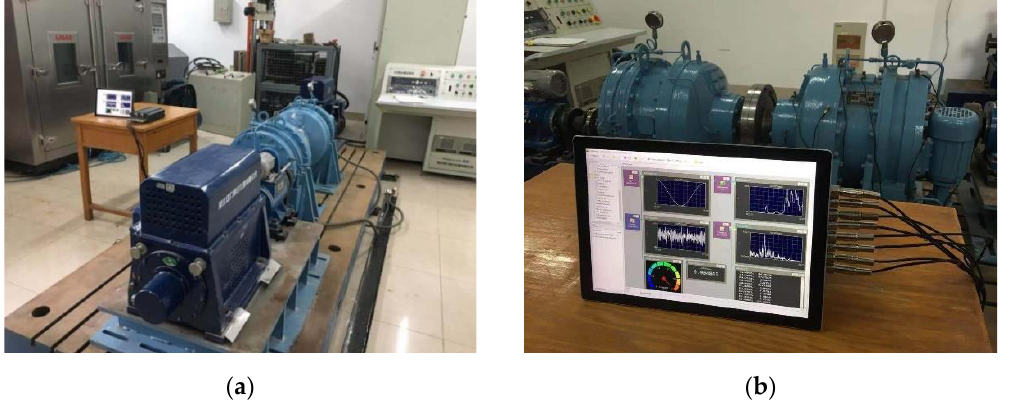
Figure 14. Bending fatigue test center. ( a ) Gearbox test bench. ( b ) Data acquisition and display. Table 2. Related parameters of standard spur gear.